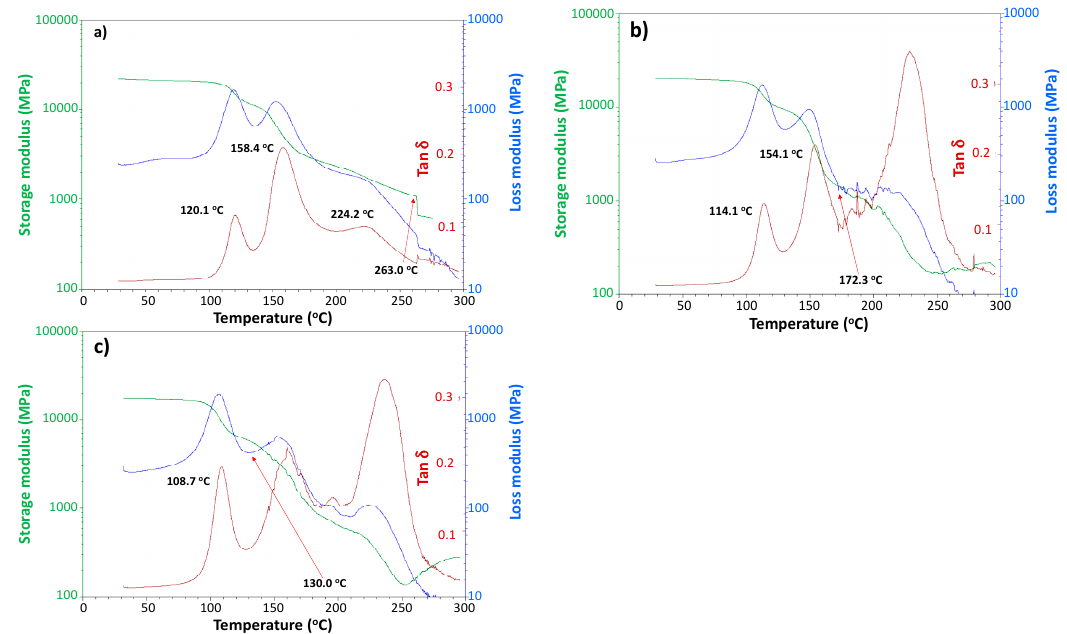
Figure 12. DMA charts of moisture-absorbed CFRP samples at 120 °C in 4 days ( a ), 140 °C in 15 days ( b ) and 160 °C in 7 days ( c ) with moisture.